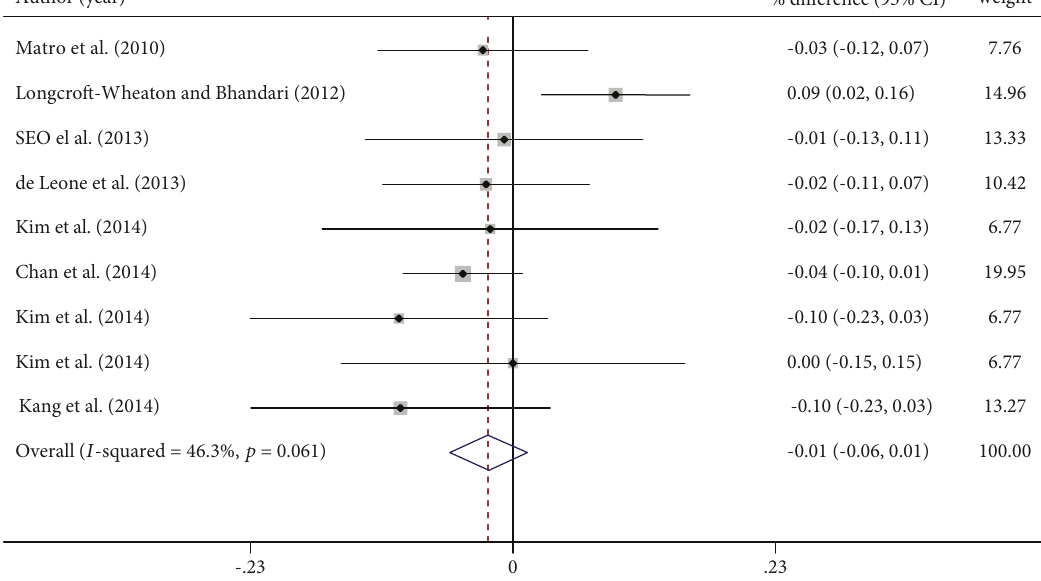
Figure 3: Percentage di ff erence (expressed as rate di ff erence, RD) of colon cleansing in patients assuming same-day or split bowel preparation. RD=rate di ff erence.